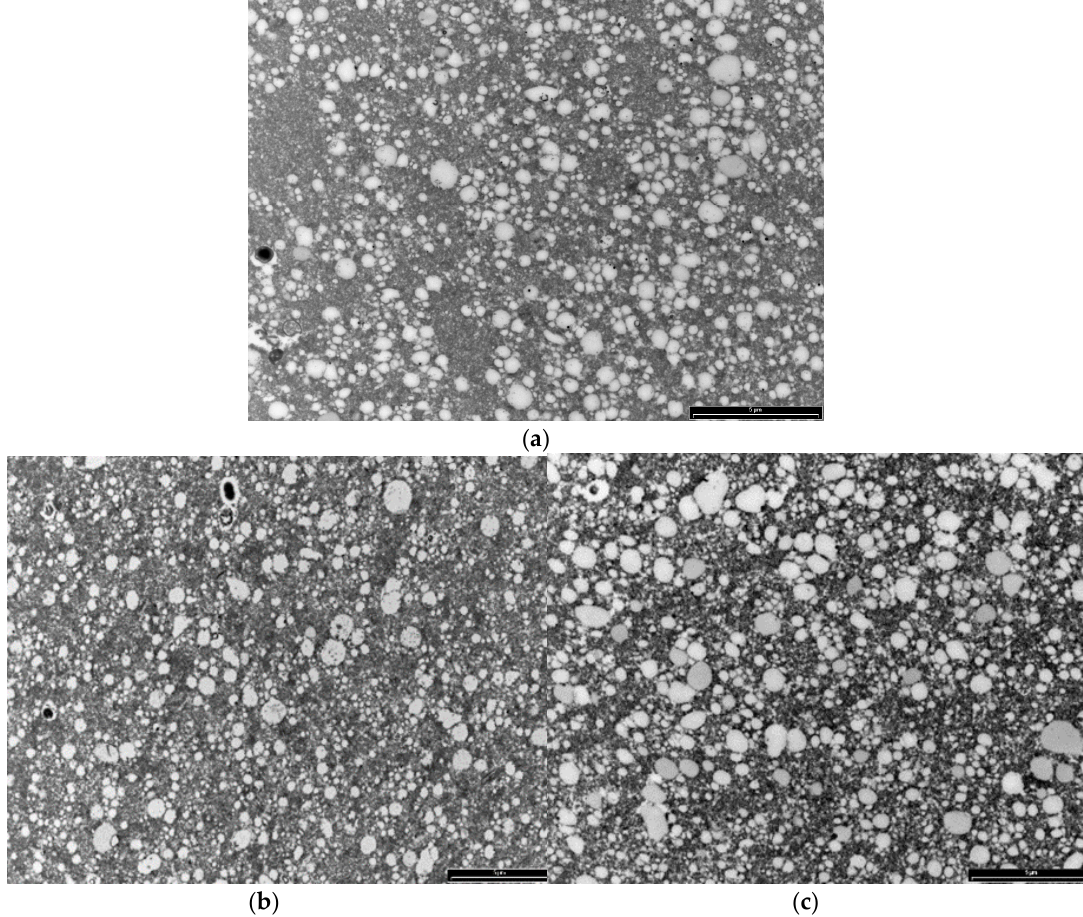
Figure 5. Transmission electron micrographs (lower magnification) of mature full-fat cheese samples ( a ) no catechin (control cheese), ( b ) 250 ppm free (+)-catechin and ( c ) 500 ppm free (+)-catechin. The white areas represent fat globules, and the dark areas are protein (casein) matrix surrounding the fat globules. Scale bar: 5 µm.